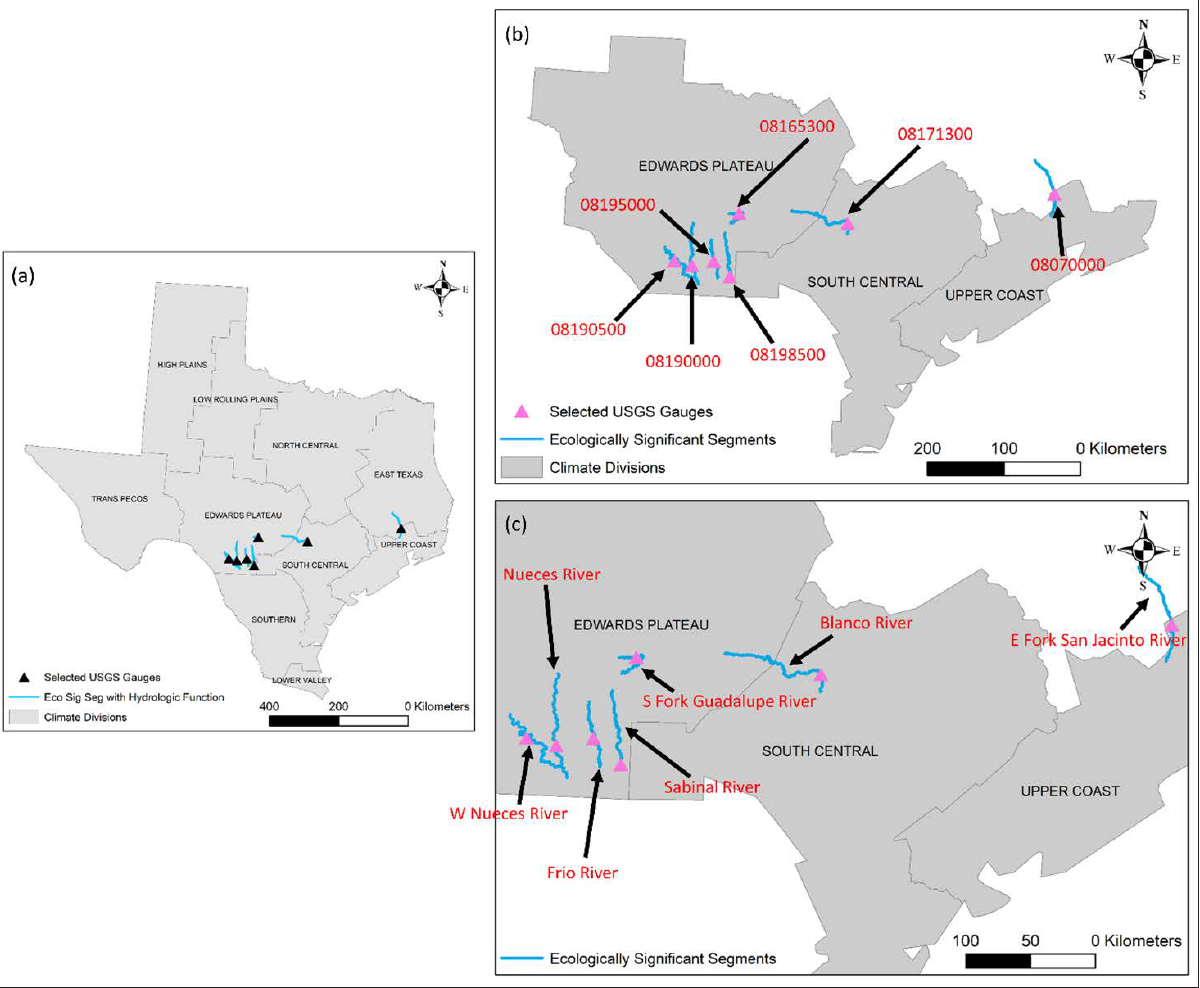
Figure 1. (a) Climate divisions of Texas; (b) location and number of USGS sites with continuous daily records from 1969- 10-01 to 2019-09-30 relative to the climate divisions; (c) names of the ecologically significant stream segments in this